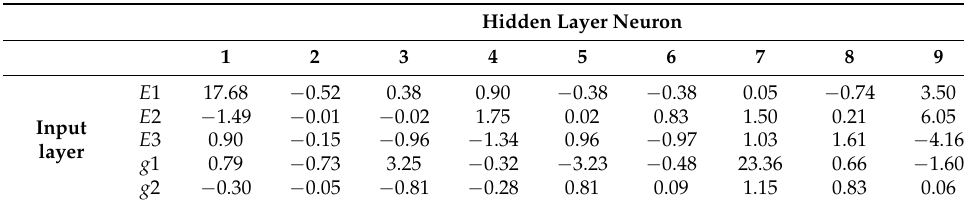
Table 3. Input layer to hidden layer weights for T1.